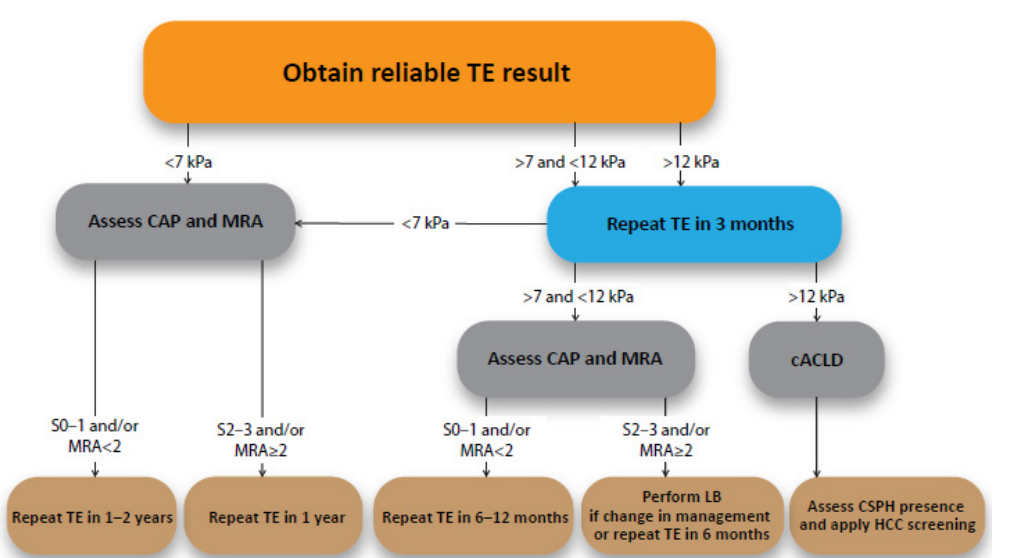
Figure 3. Assessing liver fibrosis in MAFLD patient. Any reliable TE >21 kPa is sufficient to rule cACLD in. TE—transient elastography. CAP—controlled attenuation parameter. MRA—metabolic risk abnormalities (see Figure 1). cACLD—compensated advance chronic liver disease. LB—liver biopsy. CSPH—clinicaly significant portal hypertension. HCC—hepatocelular carcinoma.